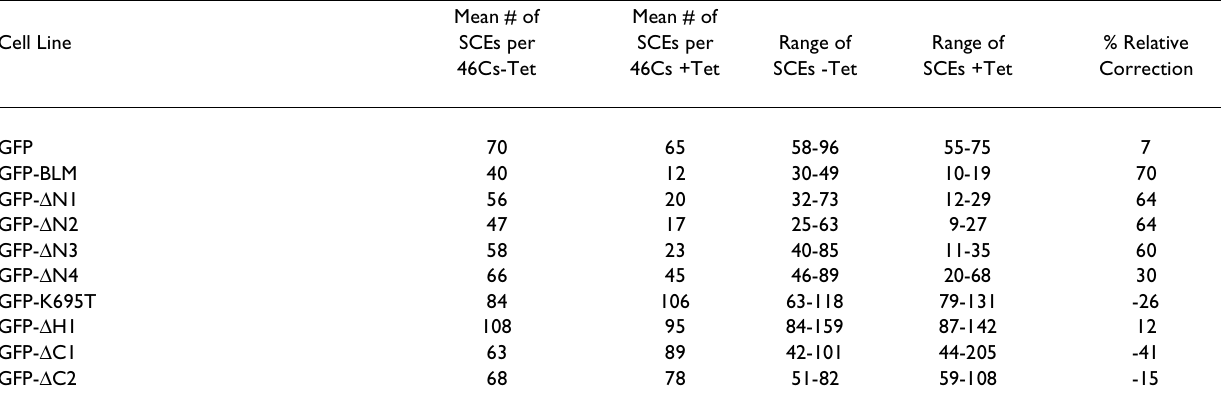
Mean # of Mean # of